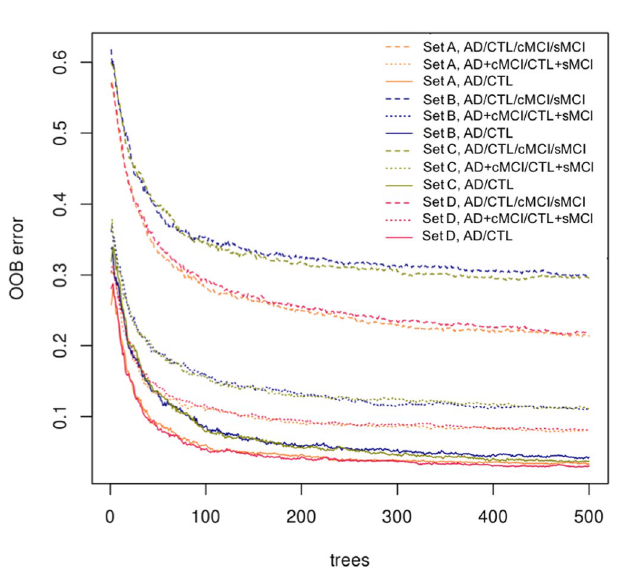
Figure 2. Performance of Random Forest models for different feature sets and three tested ways of classification. Tested feature sets: ( A ) metabolic features only, ( B ) metabolic and genomic features, ( C ) metabolic and genomic features together with sample covariates, and ( D ) metabolic features with sample covariates. Tested ways of classification: original multi-class—AD/CTL/cMCI/sMCI, binary over-sampling—AD + cMCI/ CTL + sMCI, and binary under-sampling— AD/CTL. The best performing final model: set ( D ), binary under- sampling classification AD/CTL. The x-axis shows a number of trees used in the Random Forest run. The y-axis shows the Out-Of-Bug (OOB) prediction